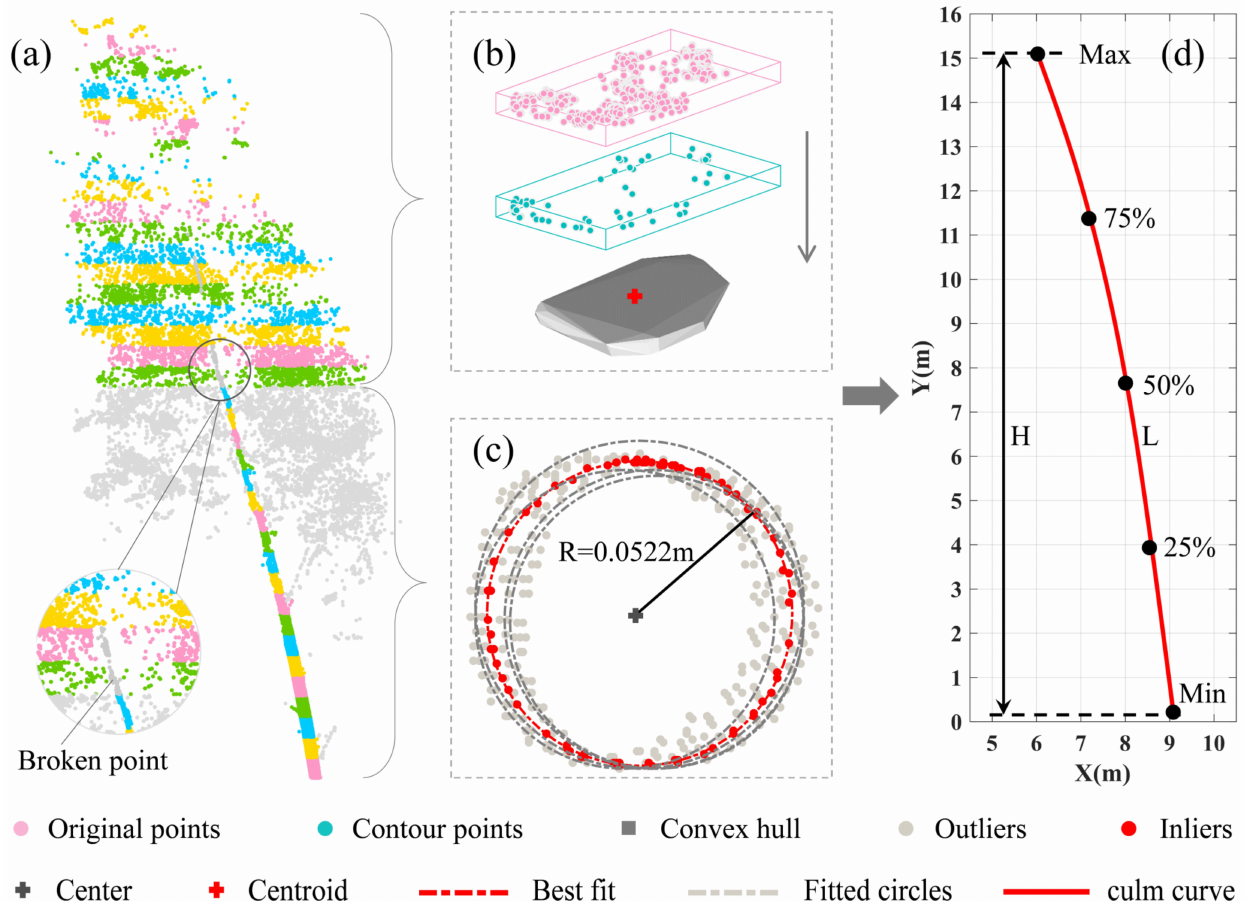
Figure 6. Process of bamboo culm axis construction: ( a ) The point cloud used to extract the cross- section center points; ( b ) extraction of the centroid of point cloud using convex hull; ( c ) extraction of circle center using RANSAC; ( d ) construction of bamboo culm axis using cubic B-spline